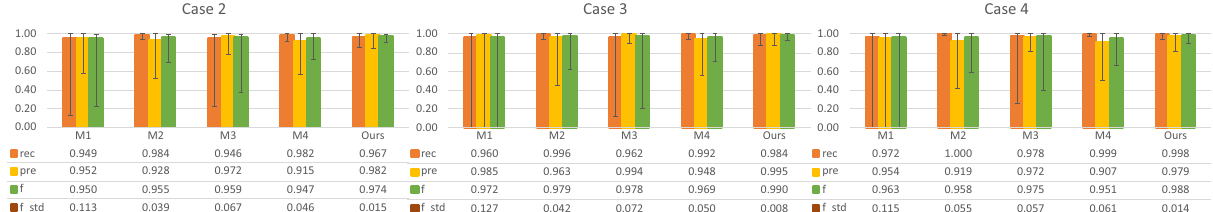
Figure 10. Summary of the quality obtained with our strategy and 4 other segmentation methods. The error bars report the best and worst result for each metric across the whole dataset, showing the robustness of our